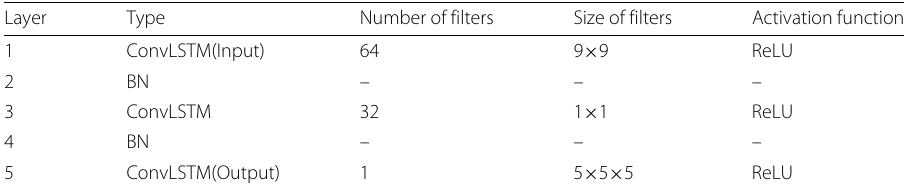
Table 1 Architecture of the